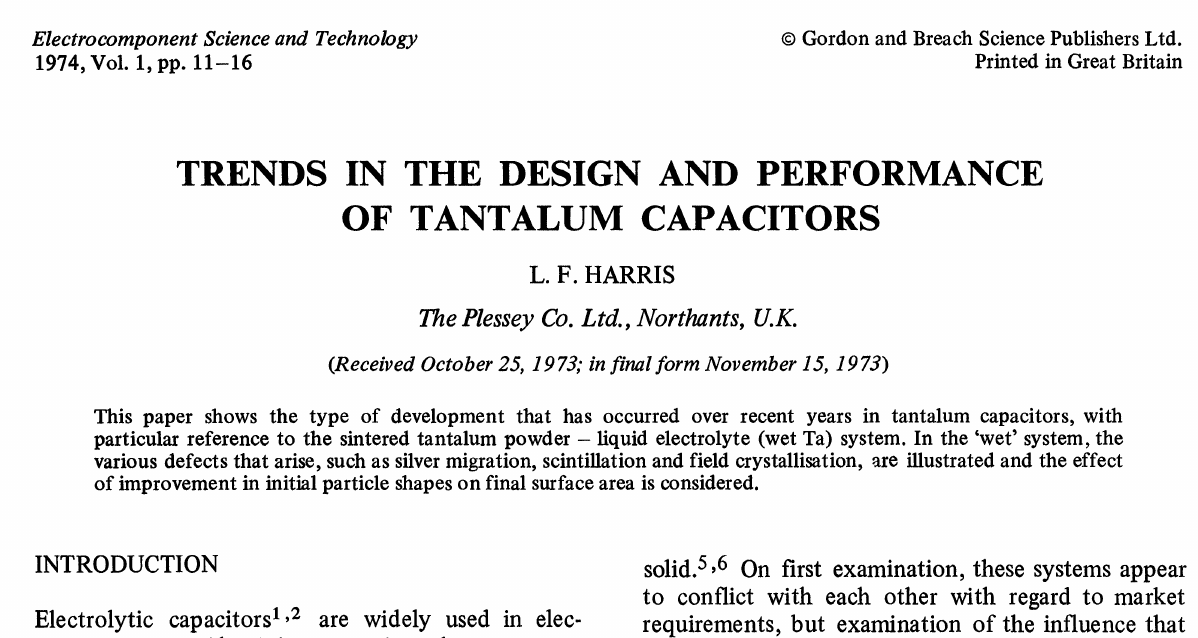
TABLE Comparative performance of tantalum electrolytic capacitors (Code: best, 3